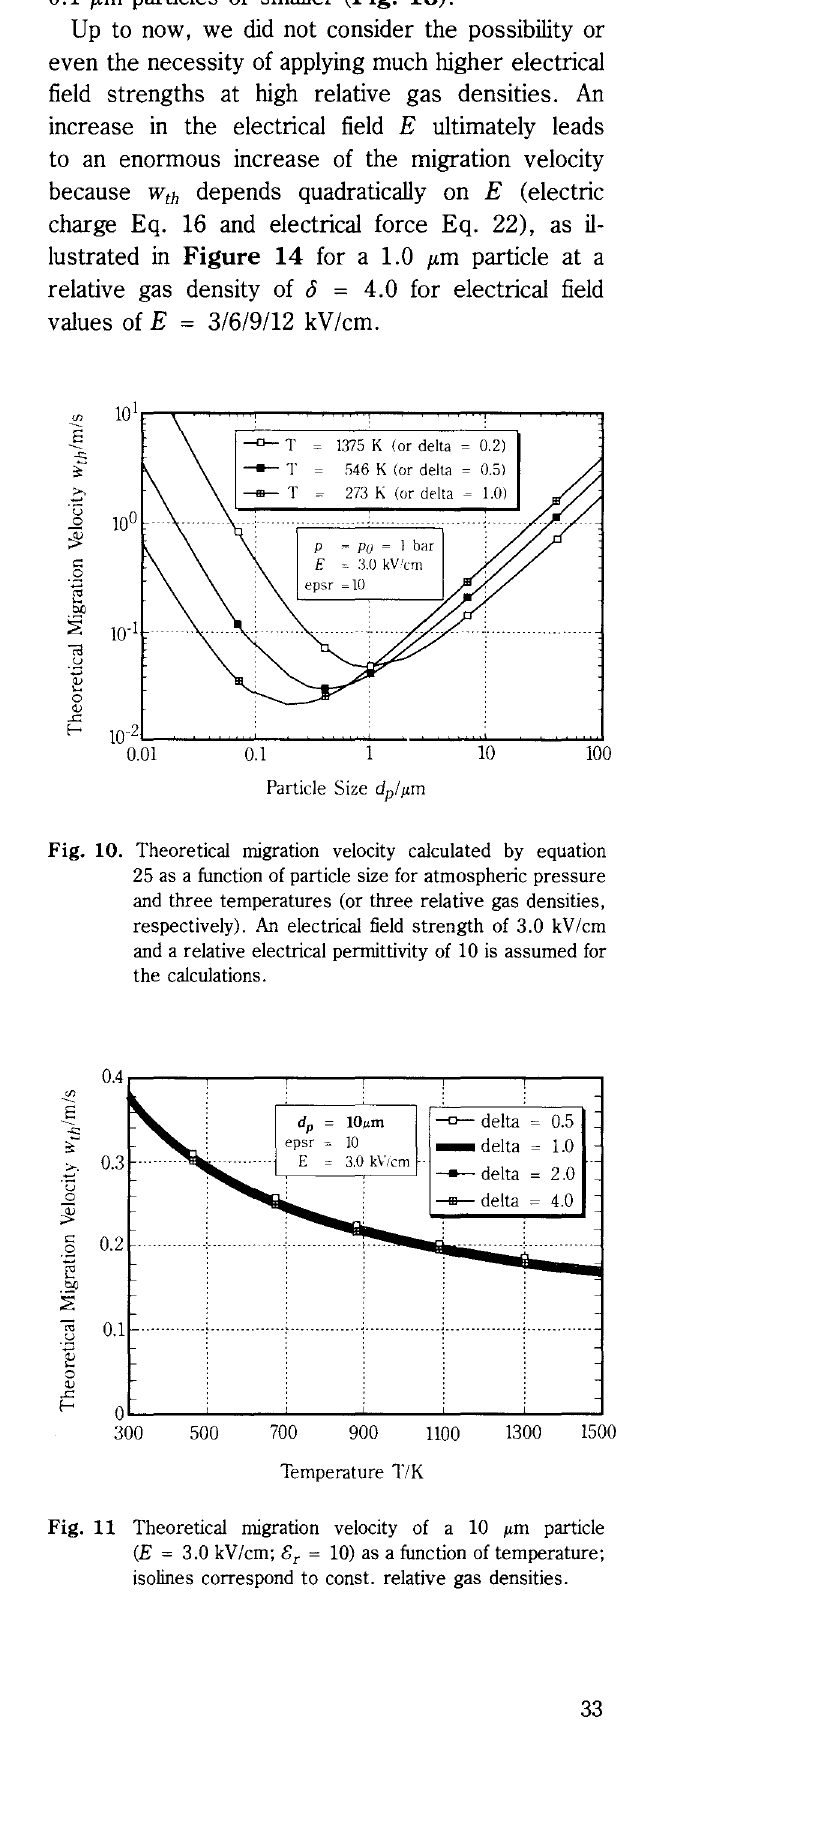
Fig. 11 Theoretical migration velocity of a 10 Jim particle (E = 3.0 kV/cm; 6r = 10) as a function of temperature; isolines correspond to const. relative gas